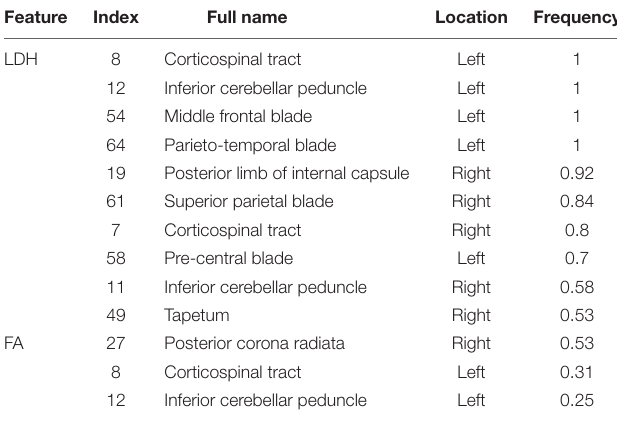
TABLE 2 | Full name and frequency of each brain structure in the optimal feature subset of LDH and